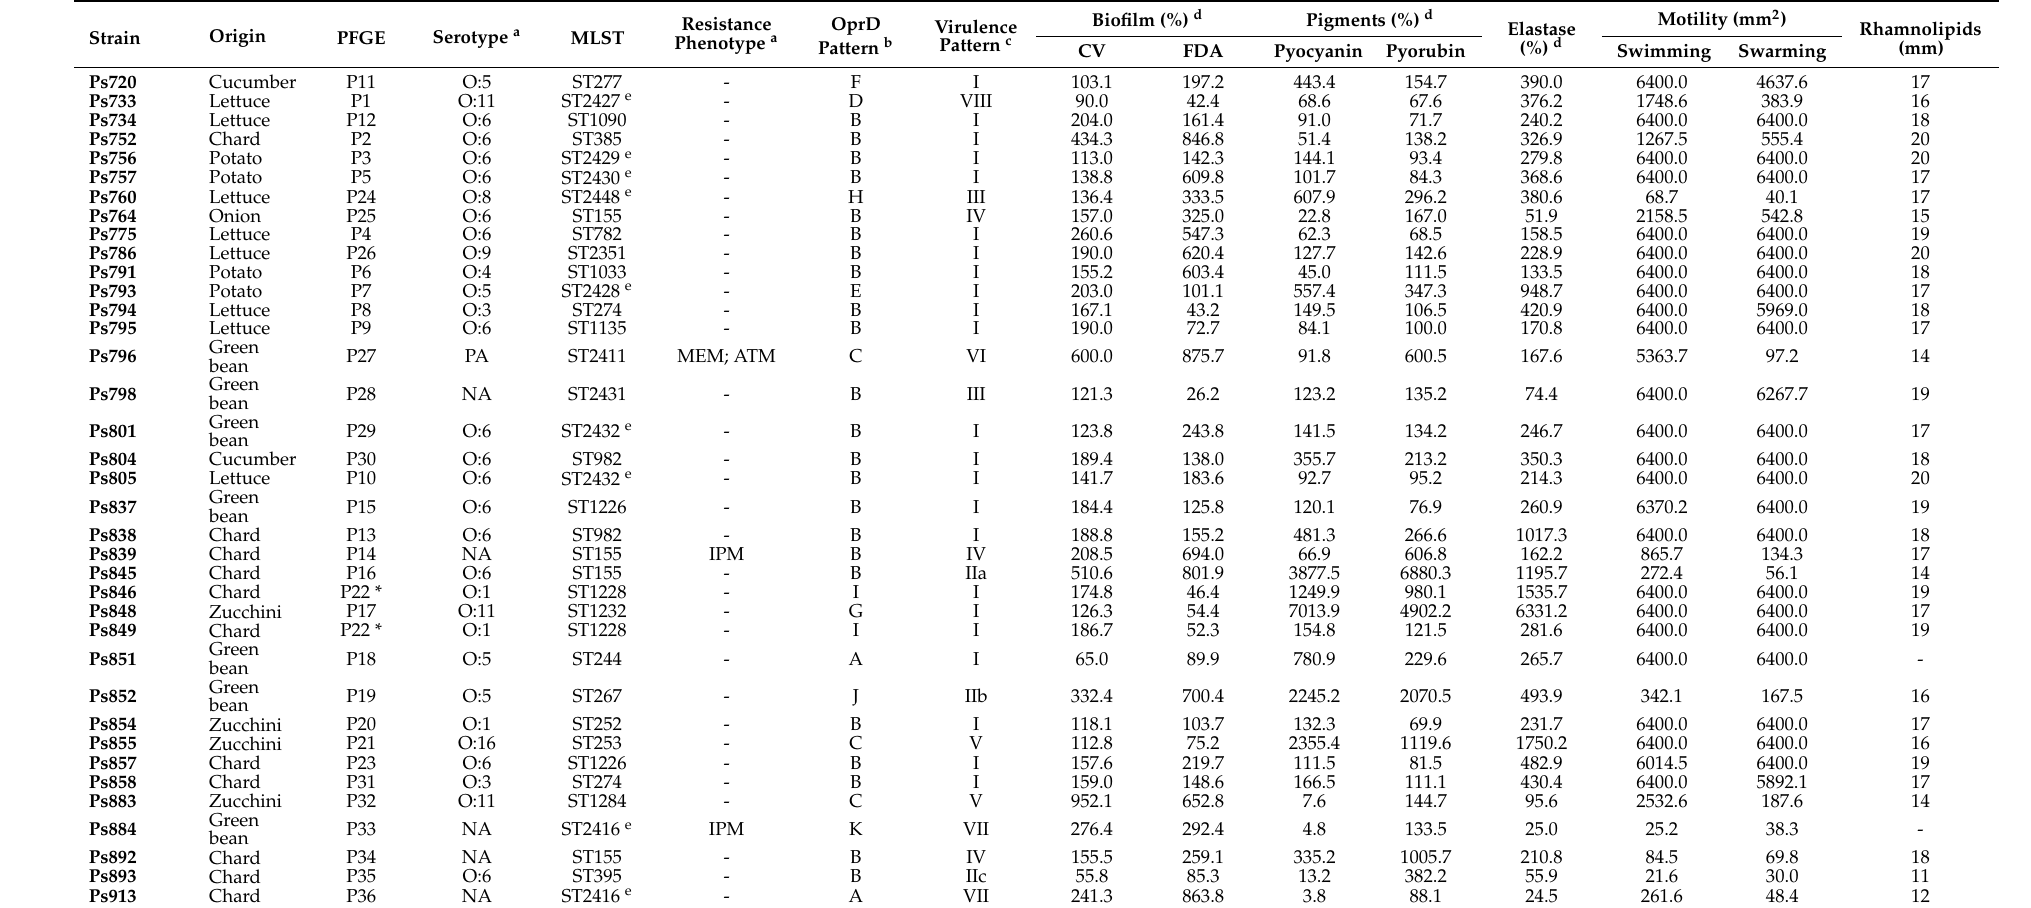
Table 2. Genotypic and phenotypic characteristics of the 37 P. aeruginosa strains recovered from food